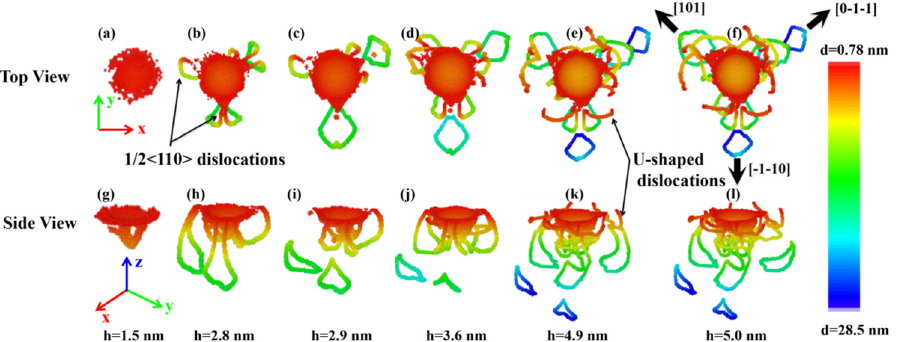
Figure 11. The microstructure evolution under the indented (111) plane of ZnSe nano film at different indentation depth. Atoms are colored with z-value. ( a ), ( b ), ( c ), ( d ), ( e ), and ( f ) are the top views of the structures at the indentation depth of 1.5 nm, 2.8 nm, 2.9 nm, 3.6 nm, 4.9 nm, and 5.0 nm, respectively. ( g ), ( h ), ( i ), ( j ), ( k ), and ( l ) are the side views of the structures at the indentation depth of 1.5 nm, 2.8 nm, 2.9 nm, 3.6 nm, 4.9 nm, and 5.0 nm, respectively.